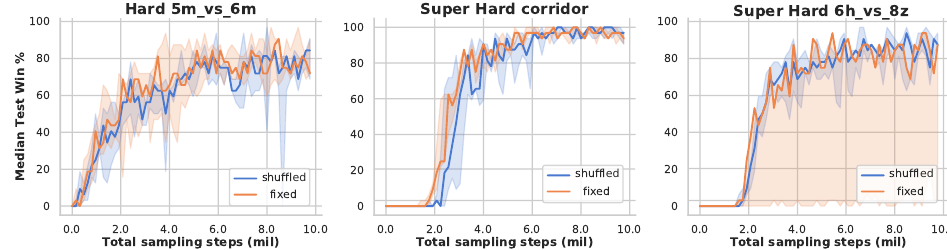
Figure 8. The performance comparison of fixed sampled noise vectors and shuffled noise